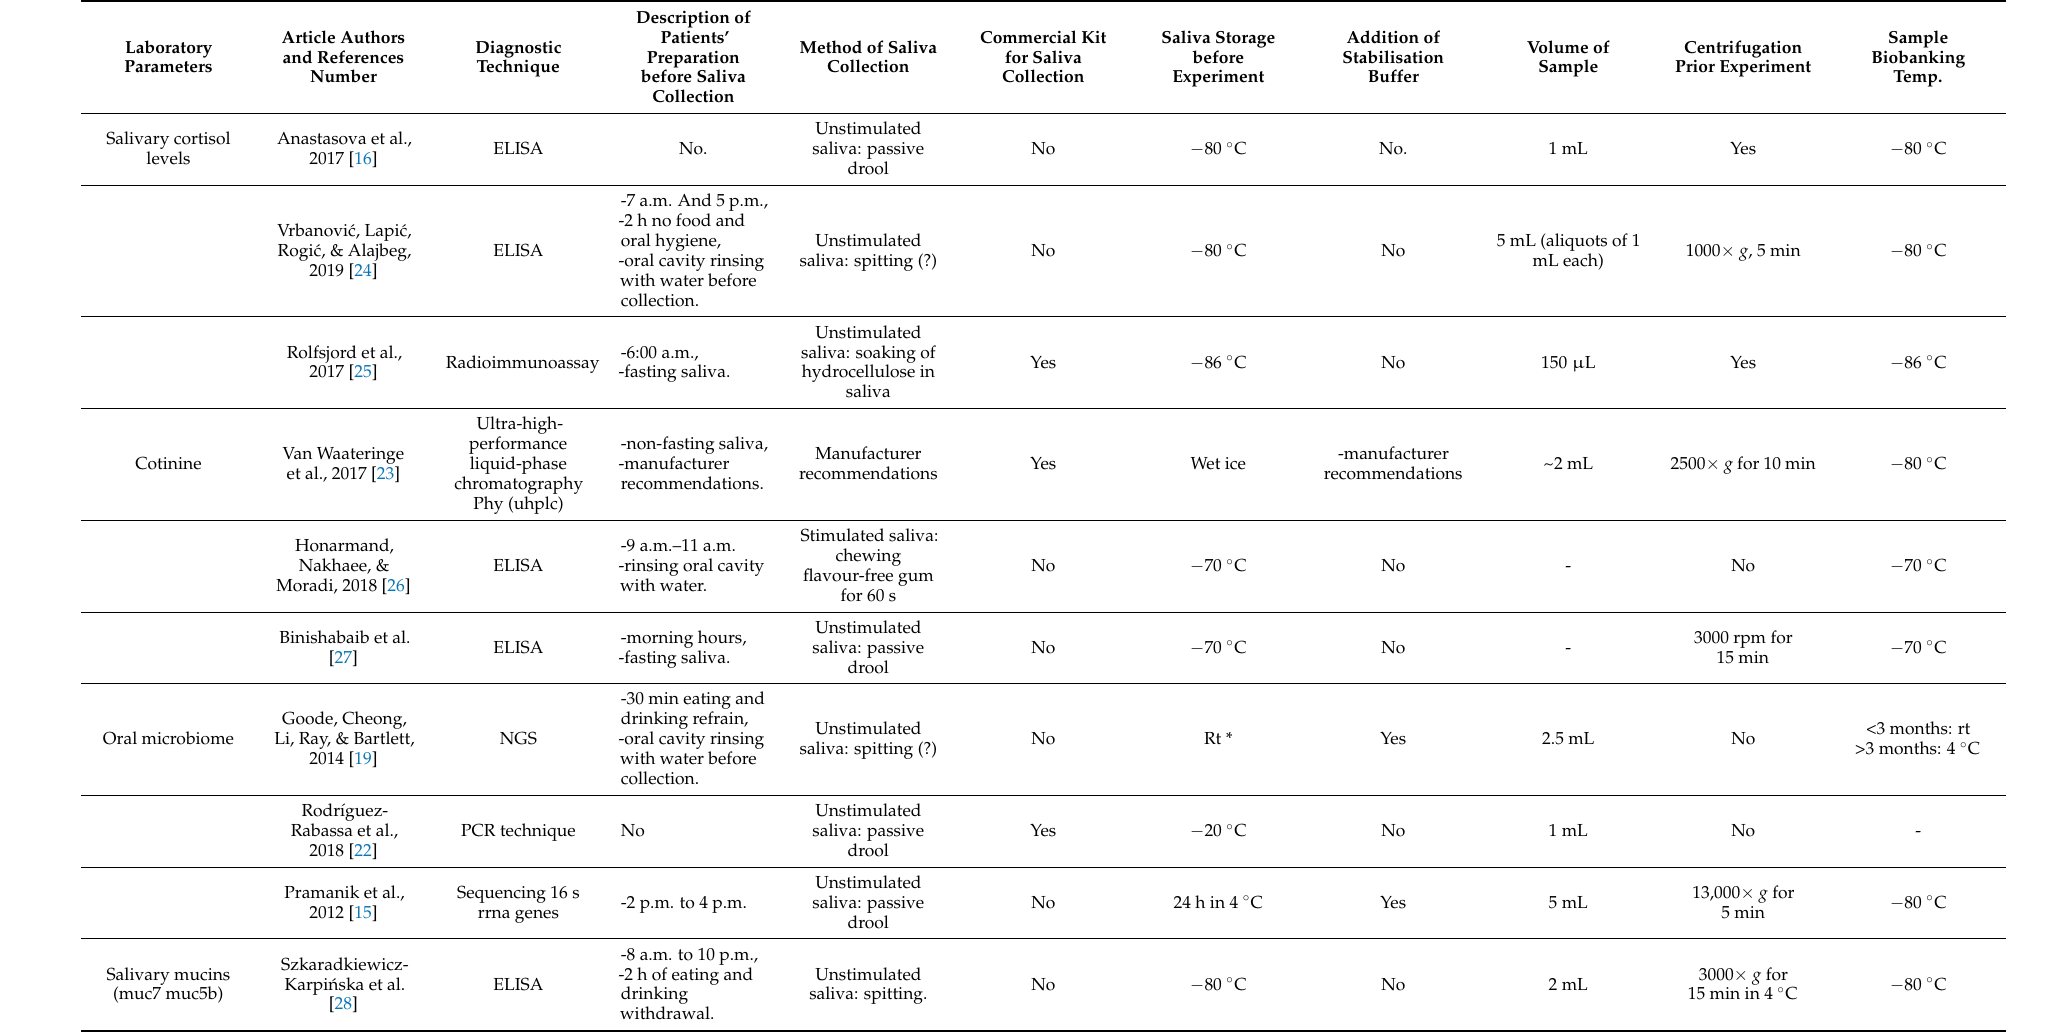
Table 2. The comparison of saliva preparation and pre-analytical